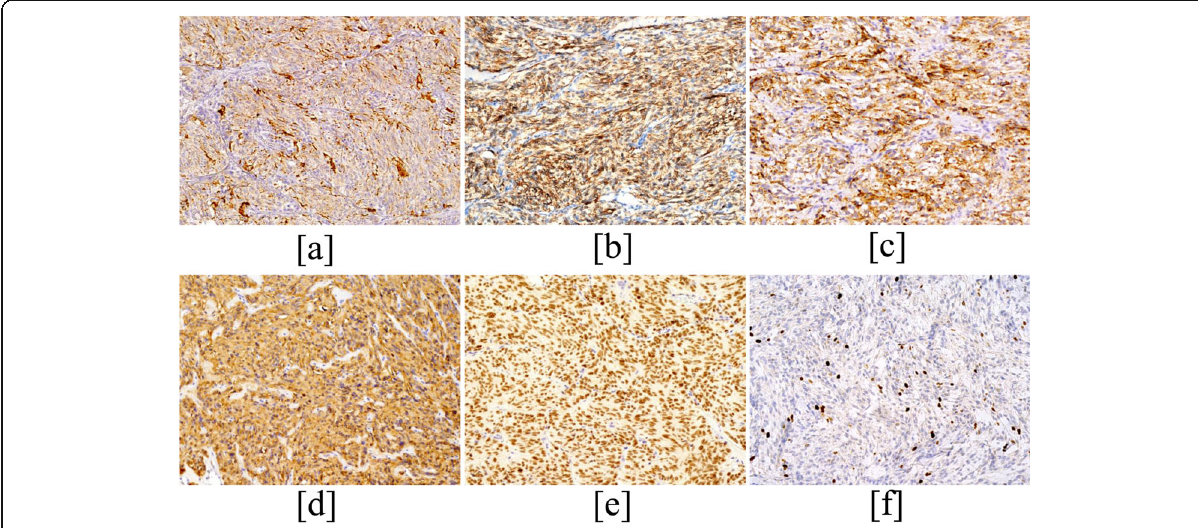
Fig. 2 Immunohistochemistry. The tumor cells are positive for CT ( a ), CD56 ( b ), CgA ( c ) and Syn ( d ) in the cytoplasm (Original magnification, × 200). The tumor cells are positive for TTF-1( e ) and Ki-67 ( f ) in the the nucleus (Original magnification, × 200)